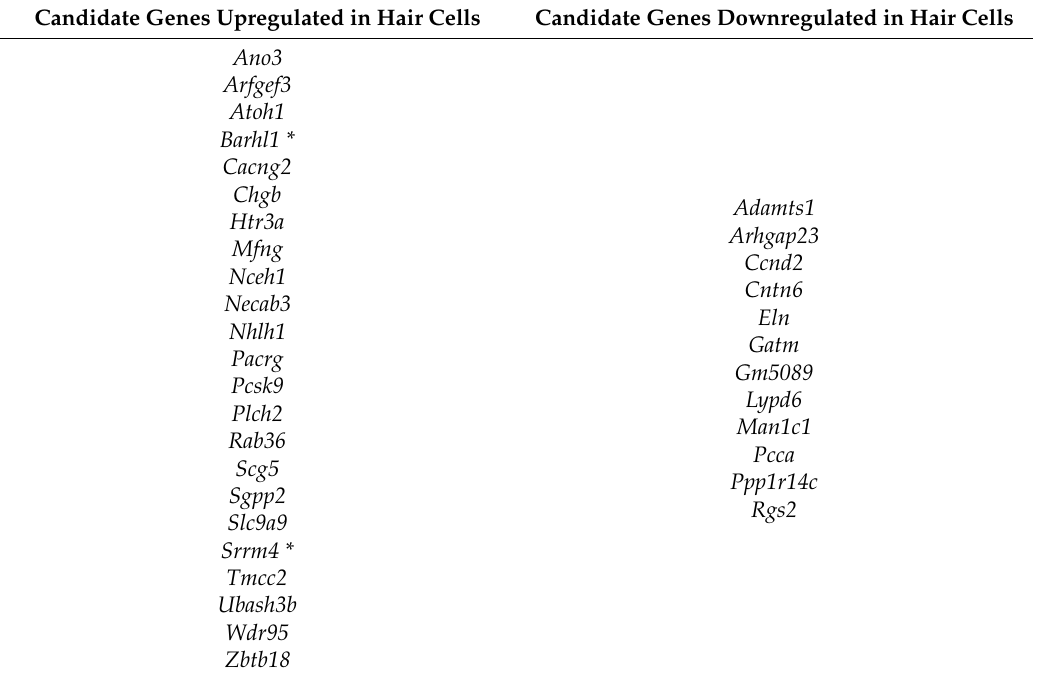
Figure 1. Potential Atoh1 direct target genes in hair cells. Schematic shows that by cross-referencing the 601 cerebellum Atoh1 direct target genes previously identified by Klisch et al. (2011) and 978 differentially expressed genes in the inner ear sensory epithelium identified by Scheffer et al. (2015), 35 genes were selected as candidates Atoh1 direct targets in hair cells. Table 1. 35 selected genes of Atoh1 direct targets candidates in hair cells. List of 35 identified candidate Atoh1 direct target genes, of which 23 are significantly upregulated in hair cells and 12 are significantly downregulated in hair cells. * Genes known as deafness genes expressed in hair cells.